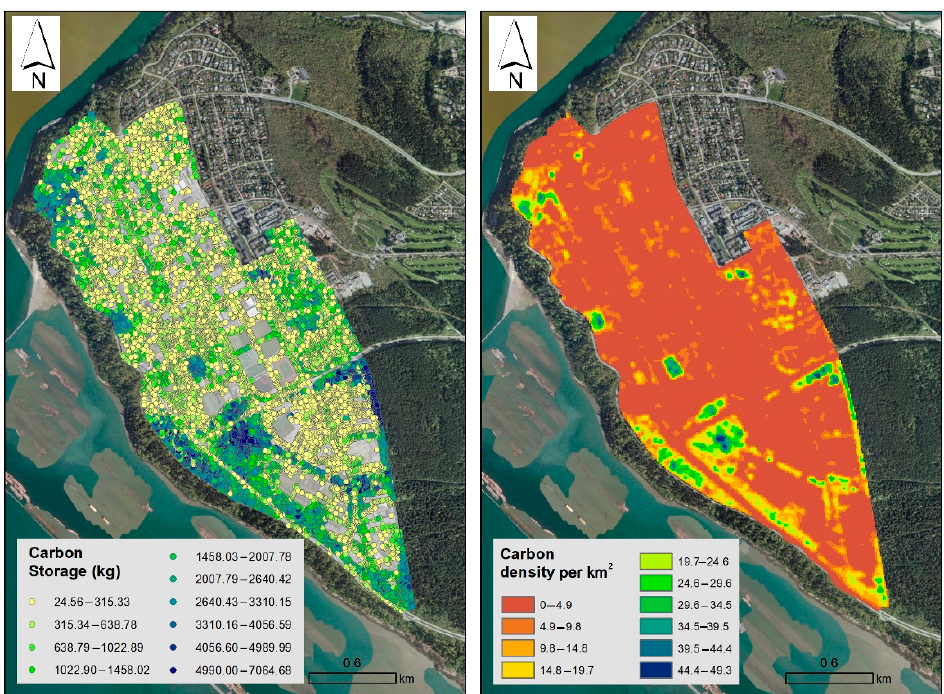
Figure 8. Kernel density and carbon storage map of the UBC campus in Vancouver, using results from the estimation model.